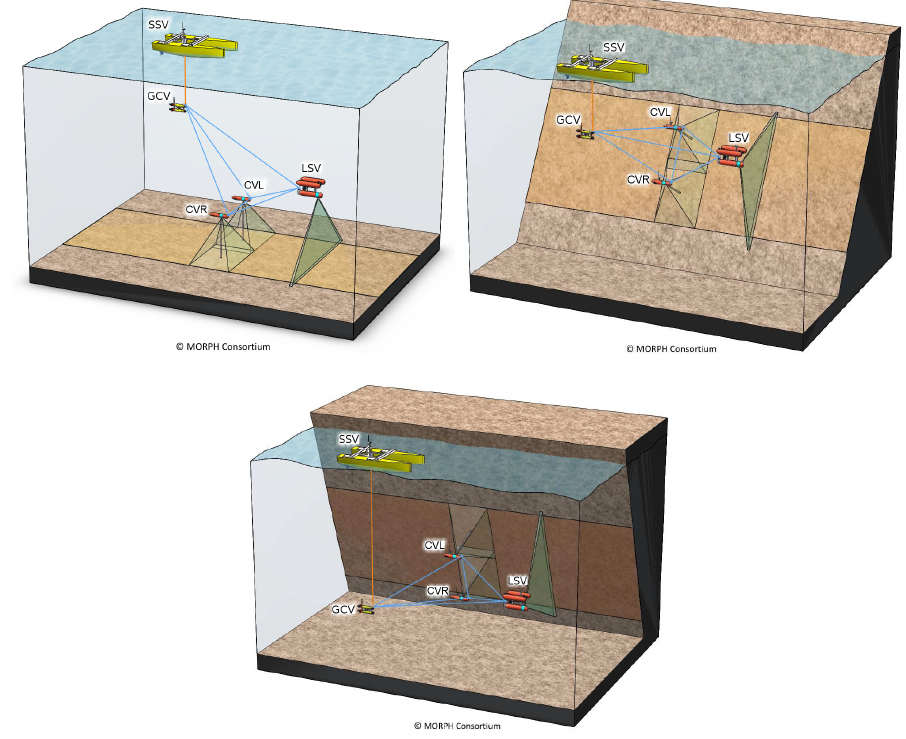
Figure 1. The formation envisioned in the Morph EU-FP7 project. Note in the 3 possible configurations shown how the Morph formation can vary depending on the shape of the area of interest being surveyed. Figures courtesy of the Morph